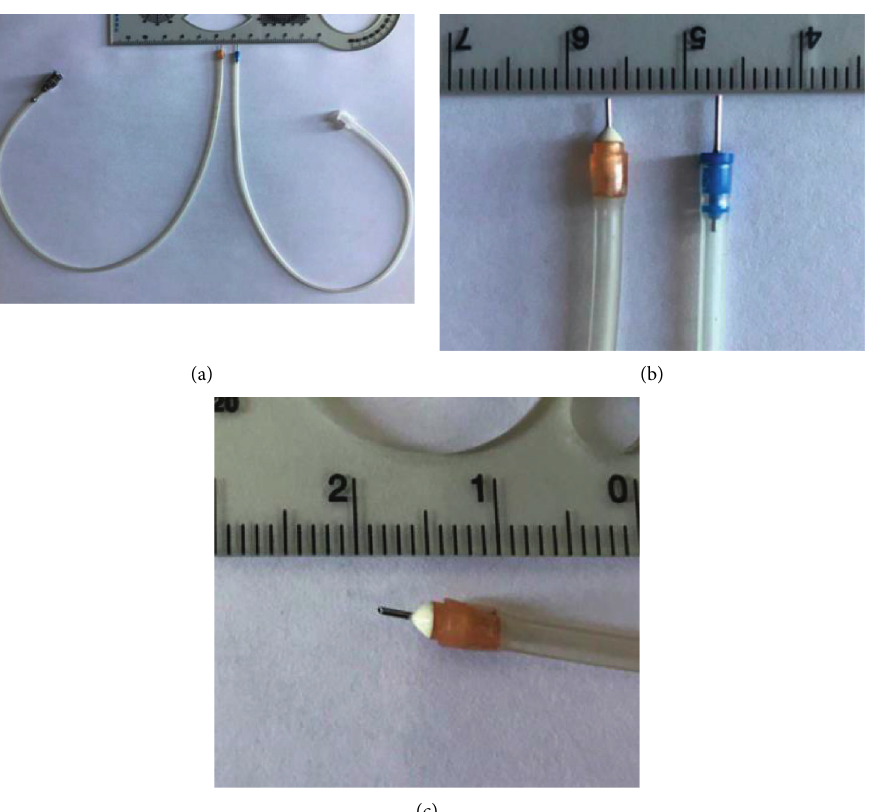
Figure 1: Anterior chamber maintainer. (a) Left one is the ACM; right one is a 25g tube. (b) The length is 1.5 mm. (c) The head is bevelled at a small angle (60 °